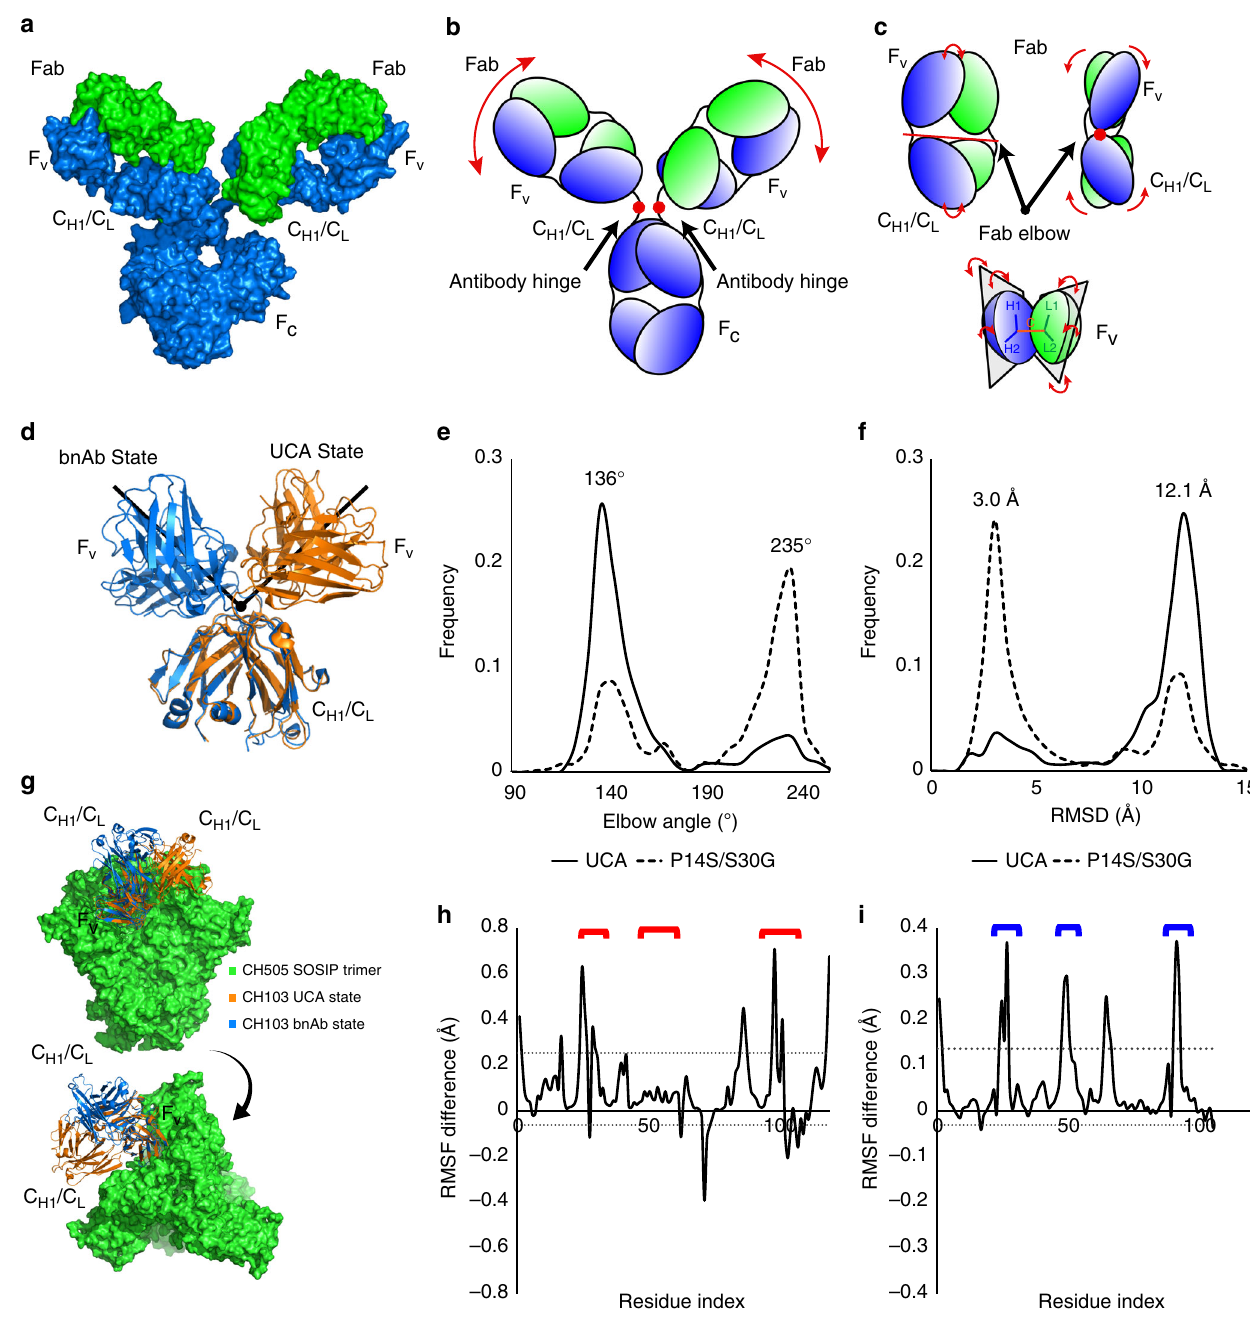
Fig. 5 Antibody structure and CH103 Fab elbow fl exibility. a Surface representation of an IgG antibody. The heavy chain (blue) and light chain (green) pair in the Fab region made up of the antigen binding F v region and the C H1 /C L region leading to the heavy chain pairing F c region. b Cartoon representation of an IgG antibody. The portion of the structure connecting the C H1 /C L region to the F c region is a site of fl exibility termed the antibody hinge. c Top: Additional antibody hinge point between the Fab F v and C H1 /C L region termed the Fab elbow. Bottom: Fab F v V H and V L orientation fl exibility about two planes. d Structural alignment of the CH103 and CH103 UCA crystal structures ’ (PDB ID 4JAM chains H and L and 4QHK chains O and P, respectively) C H1 /C L region depicting the elbow angle differences. e Elbow angle distribution for the fi ve 1 μ s simulations of the CH103 UCA (solid) and the CH103 UCA- P14S/S30G mutant (dashed). f RMSD to the CH103 bnAb (PDB ID 4JAM) distribution for the fi ve 1 μ s simulations of the CH103 UCA (solid) and the CH103 UCA-P14S/S30G mutant (dashed). g Structural superposition of the CH103 UCA and CH103 UCA-P14S/S30G onto a CH505TF SOSIP timer homology model based upon the CH103 bound gp120 con fi guration. h Aggregate simulation V H RMSF difference between the CH103 UCA-P14S/S30G mutant and the CH103 UCA. Dotted lines indicate one standard deviation from the mean. Red brackets indicate HCDR positions. ( i ) Aggregate simulation V L RMSF difference between the CH103 UCA-P14S/S30G mutant and the CH103 UCA. Dotted lines indicate one standard deviation from the mean. Blue brackets indicate LCDR